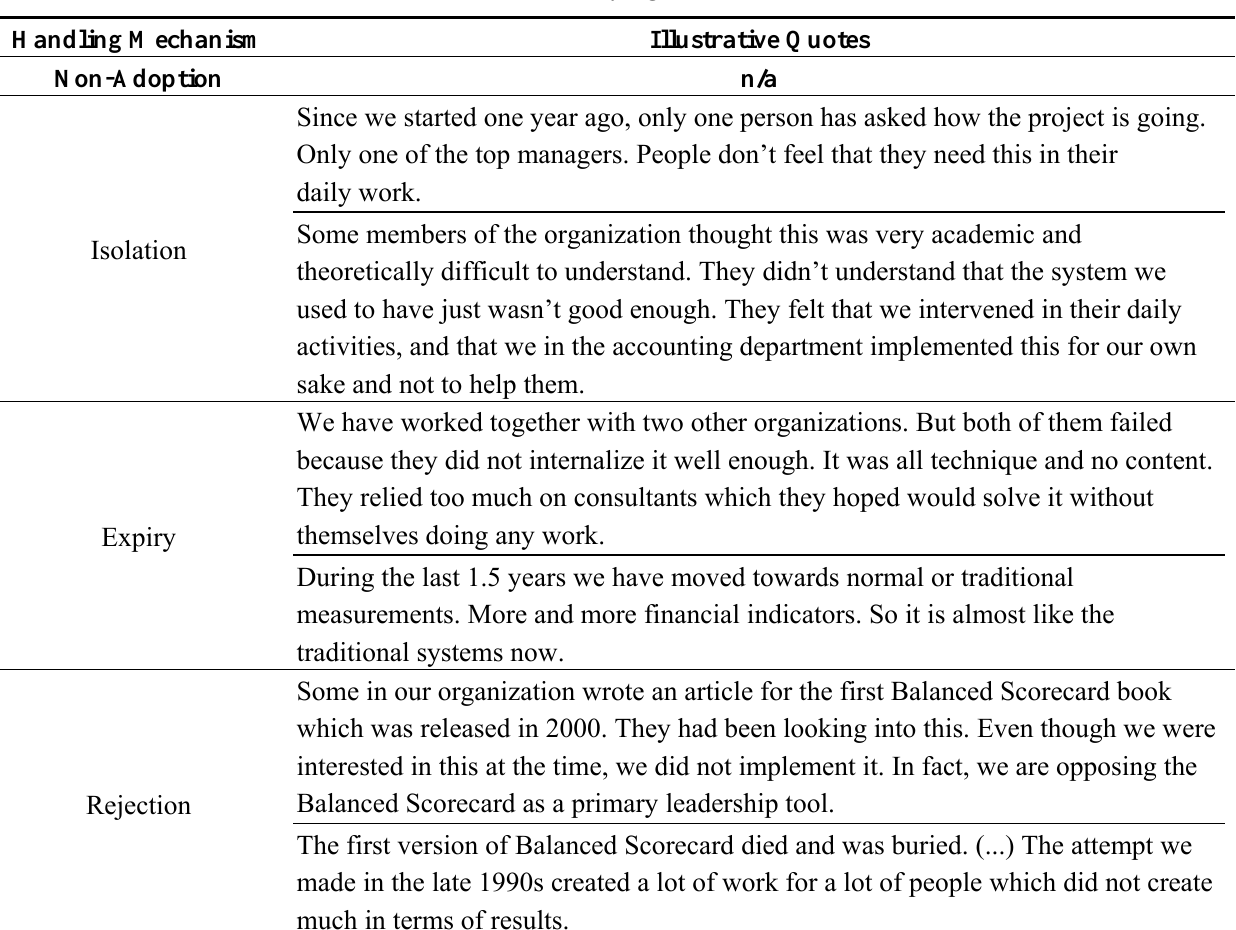
Table 8. Immunity against the